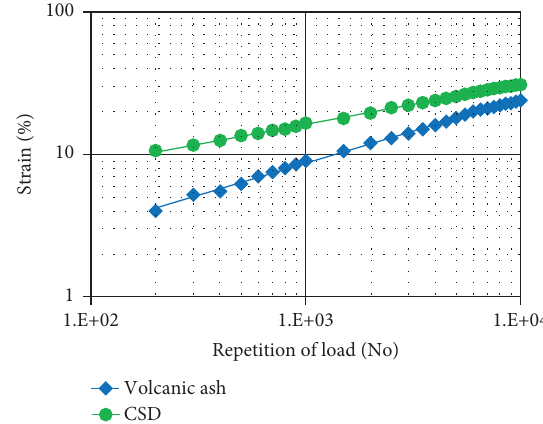
Figure 12: Impact of volcanic ash content on creep deformation.